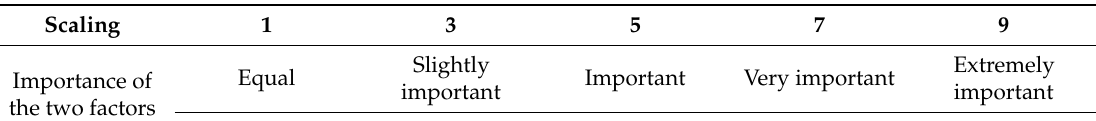
Table 2. Relative importance values of the indices.